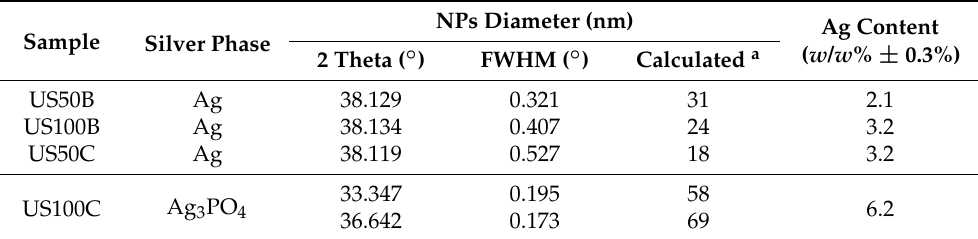
Table 2. Diameter of the silver or silver phosphate NPs obtained from the Scherrer equation and the silver content in each composite.